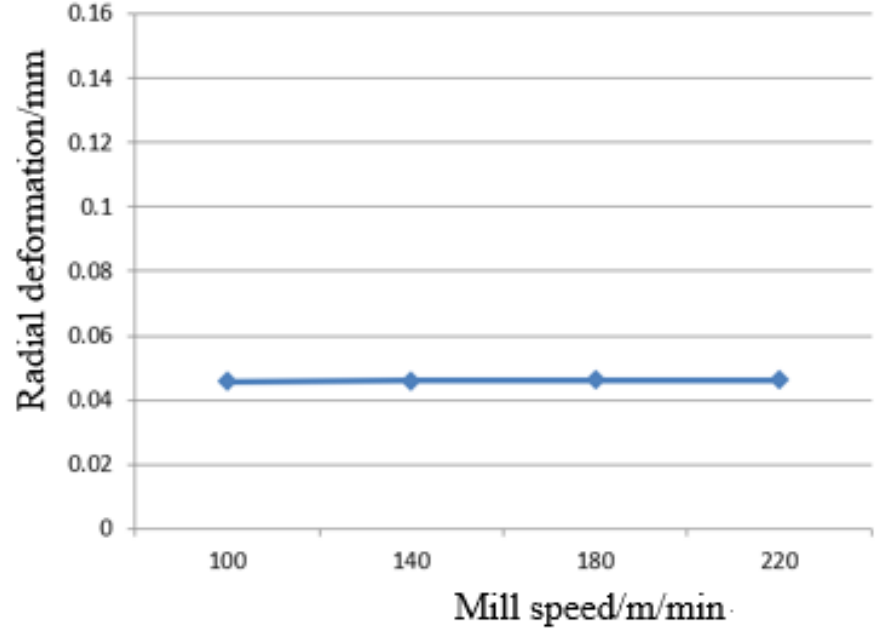
Figure 10. Influence of milling speed on radial deformation.